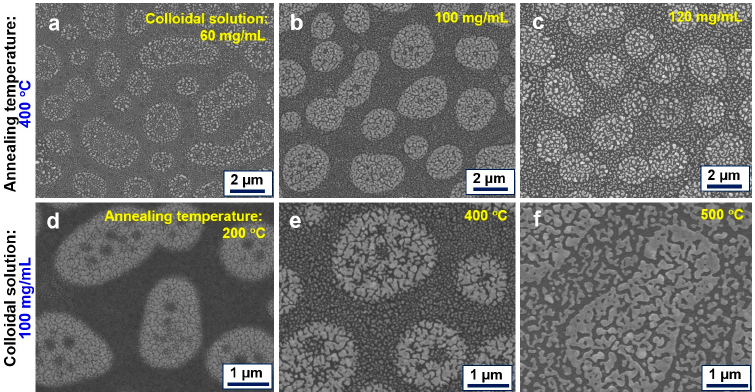
Figure 5. ( a – c ): Fabrication at an annealing temperature of 400 °C using a concentration of the colloidal solution of 60, 100, and 120 mg/mL, respectively; ( d – f ): Fabrication using a concentration of 100 mg/mL of the colloidal solution and an annealing temperature of 200, 400, and 500 °C, respectively.